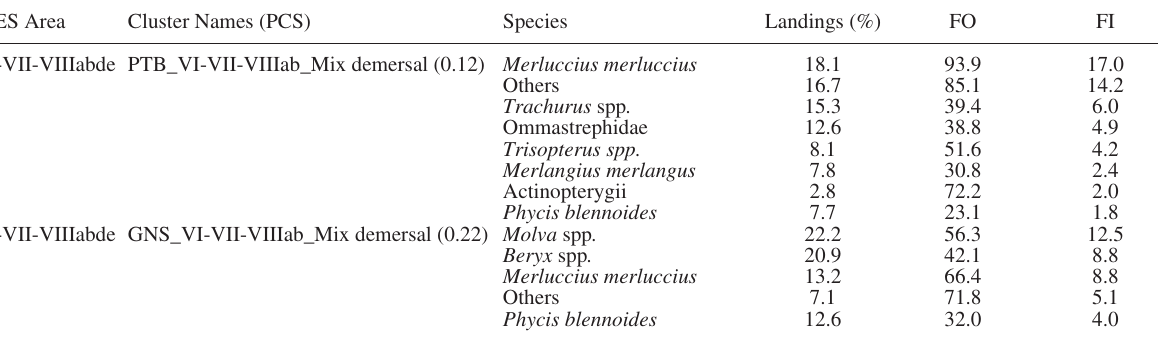
Table 3. – Catch profile (percentage in weight, frequency of occurrence and feeding index) by cluster and area for pair bottom trawl (PTB) and gillnet (GNS) (PCS: partial coefficient silhouette). ICES